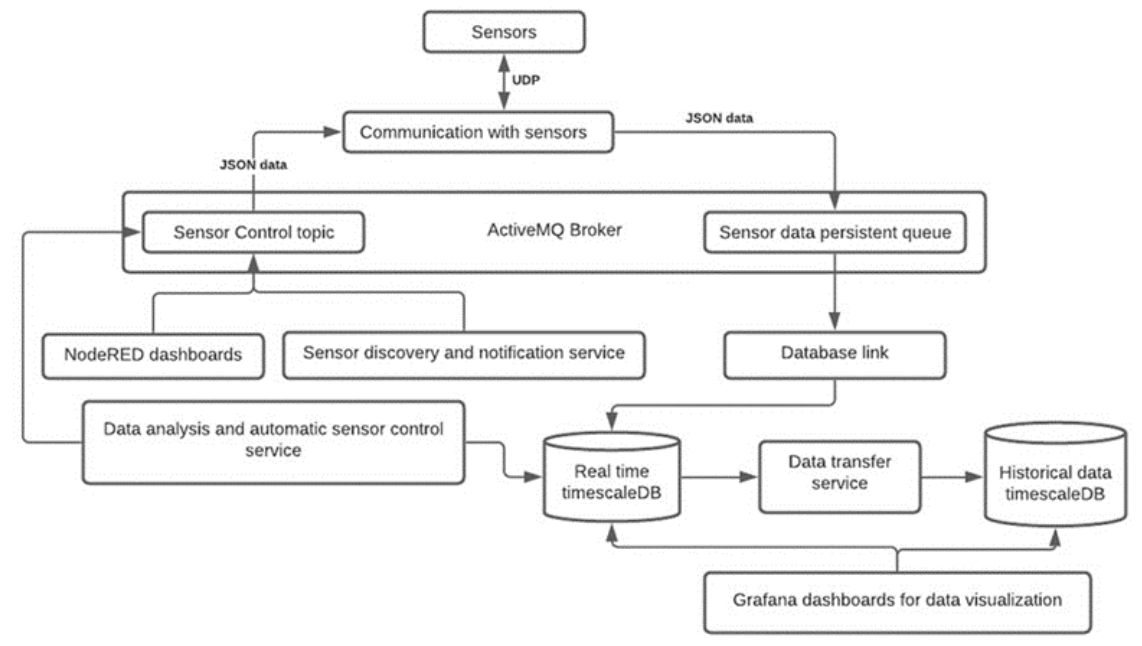
Figure 2. Software Figure 2. Software architecture.